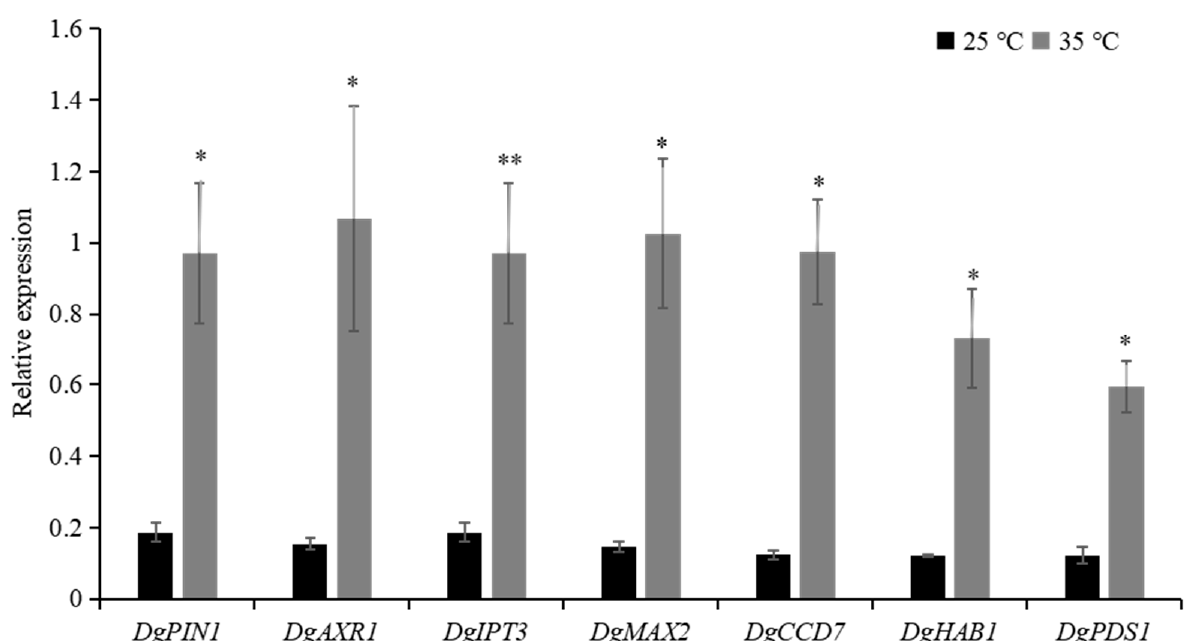
Figure 4. Expression of hormone-related genes in axillary buds 12h after secondary decapitation (bud formation) and non-decapitation under 25 ◦ C and 35 ◦ C conditions. Auxin transport gene DgPIN1 , auxin signalling gene DgAXR1 , cytokinin synthesis gene DgIPT3 , SL signal transduction gene DgMAX2, SL biosynthesis gene DgCCD7 , ABA core signal transduction gene DgHAB1 and ABA responsive gene DgPDS1 .Data are mean ± SE of three biological replicates. Asterisks indicate significant differences between treatment conditions 25 ◦ C and 35 ◦ C at * p < 0.05 and ** p < 0.01 level.